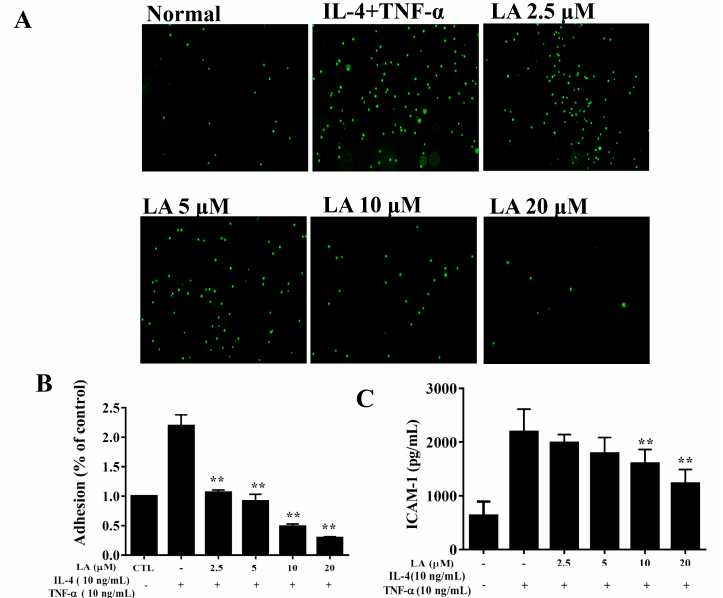
analyzed and compared to TNF- α and IL-4. Cells 2019 , 8 , x